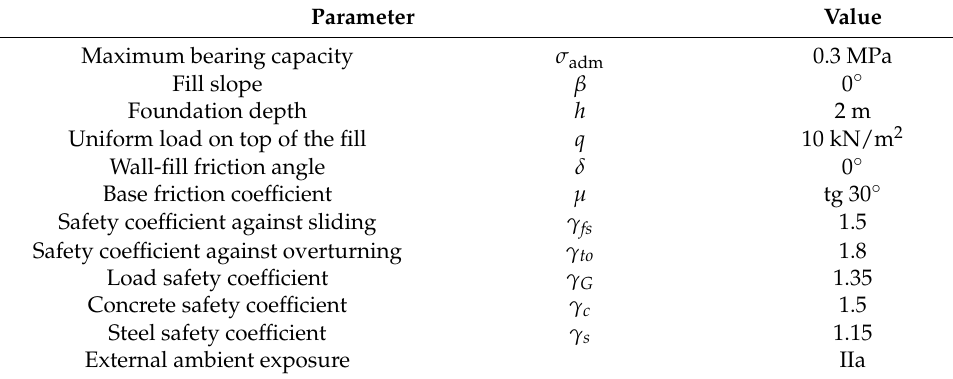
Table 3. Parameters of the buttressed